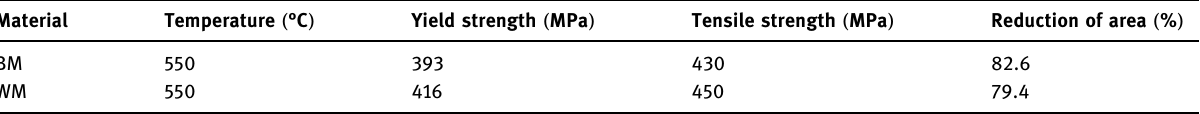
Table 3: Tensile properties of the BM and WM at 550°C Material